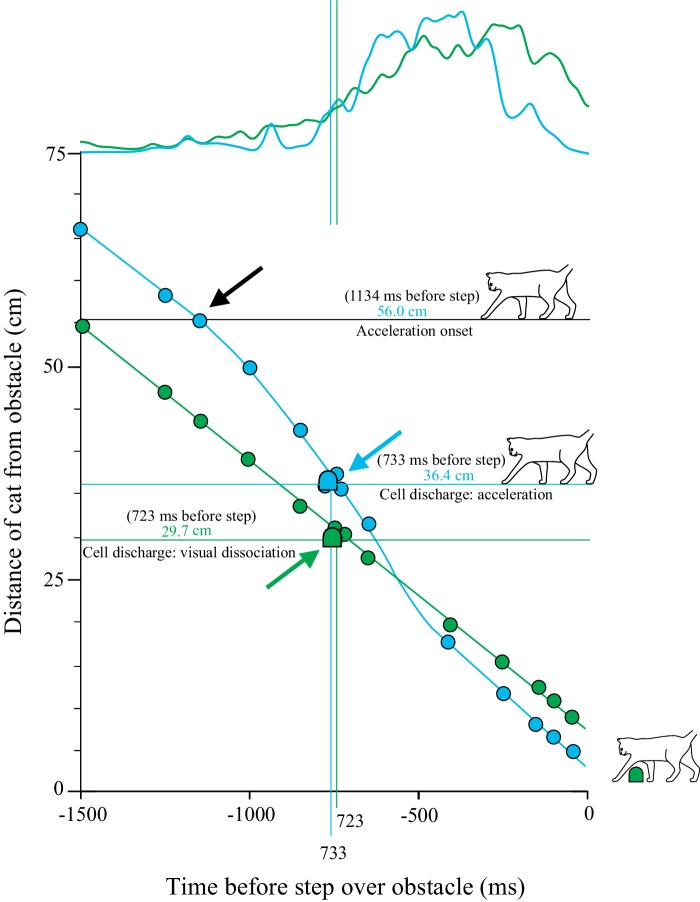
Relationship between time and distance for the visual dissociation and the 2R acceleration task.Figure organized as for Figure 7—figure supplement 2. The green arrow indicates the distance of the obstacle (29.7 cm) at the onset of the cell discharge during the unperturbed visual dissociation task (723 ms). The black arrow indicates the time at which the acceleration was applied (1134 ms before the step over the obstacle). At that time, the obstacle was 56.0 cm from the cat. Cell onset during the acceleration occurred 733 ms before the step over the obstacle (blue arrow). At this time, the obstacle was 36.4 cm from the cat, slightly farther away than when the cell fired in the unperturbed condition.